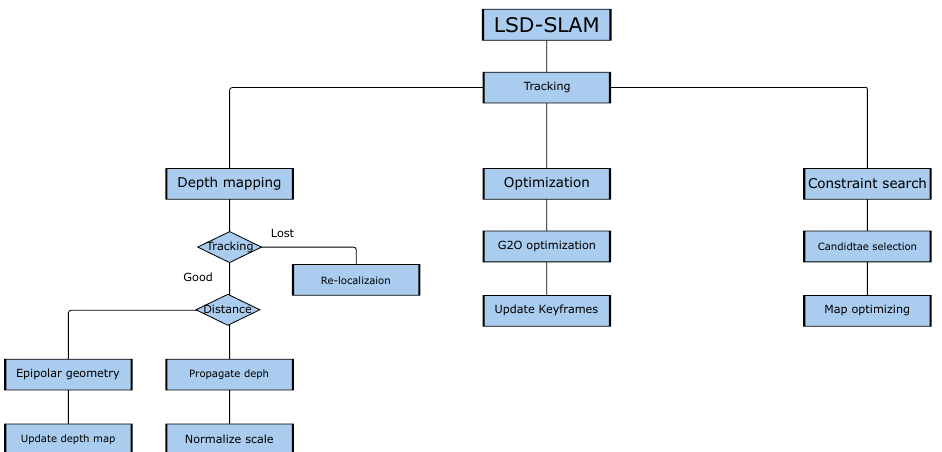
Figure 2. The architecture of LSD-SLAM [6]. G2O [36] is an optimization